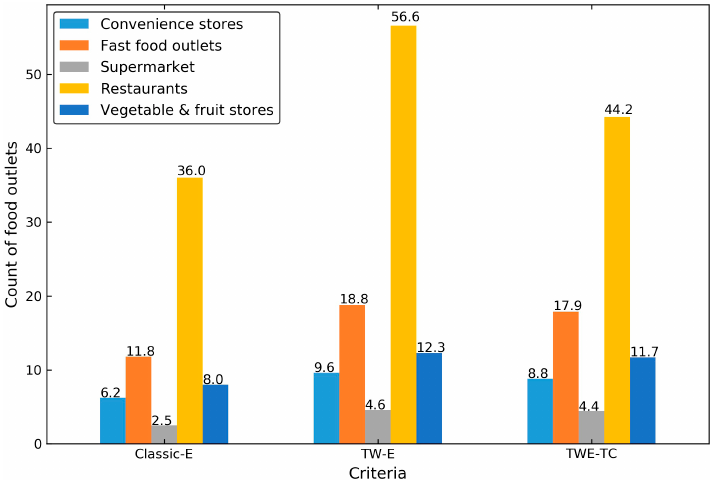
Figure 9. Average food outlet counts of the overall foodscape using Classic ‐ E, TW ‐ E, and TWE ‐ TC, stratified by food outlet types.